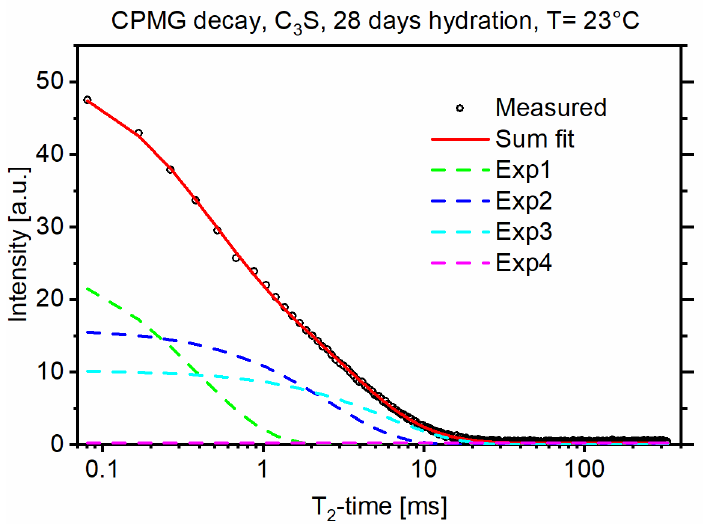
Figure 2. CPMG decay of a 28-d hydrated C 3 S sample (black circles) with the multiexponential fitting results using four exponential decay functions.